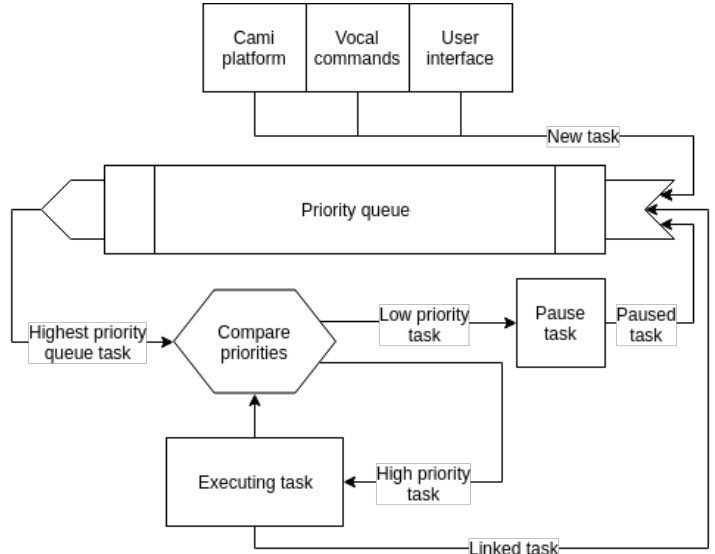
Figure 7. Conceptual overview of the information flow within the behavior execution